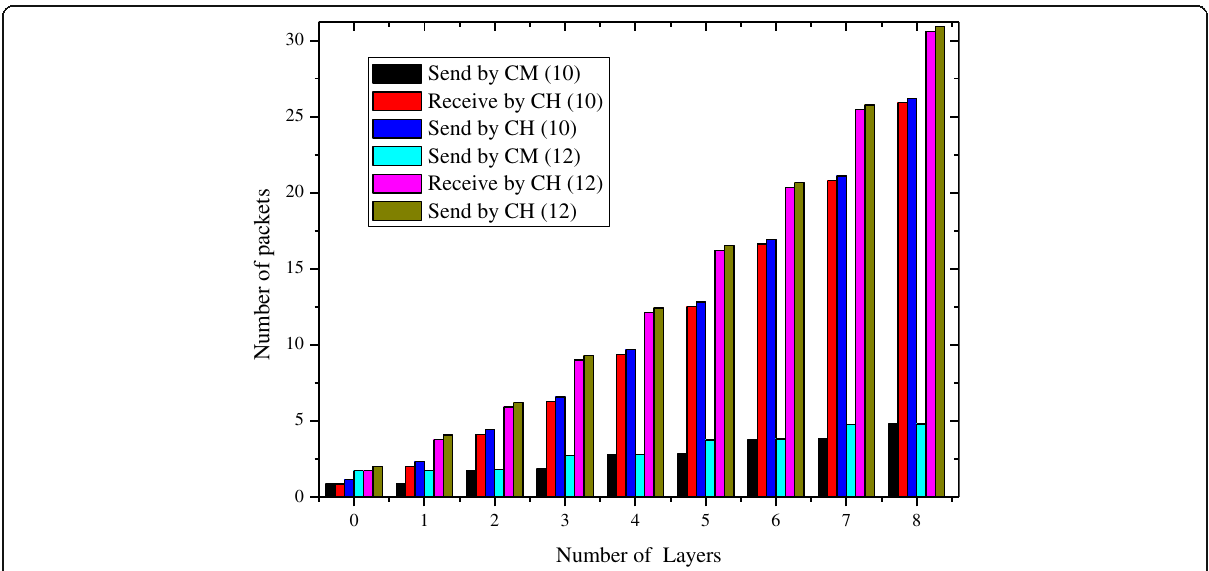
Fig. 5 The number of packets when d CM